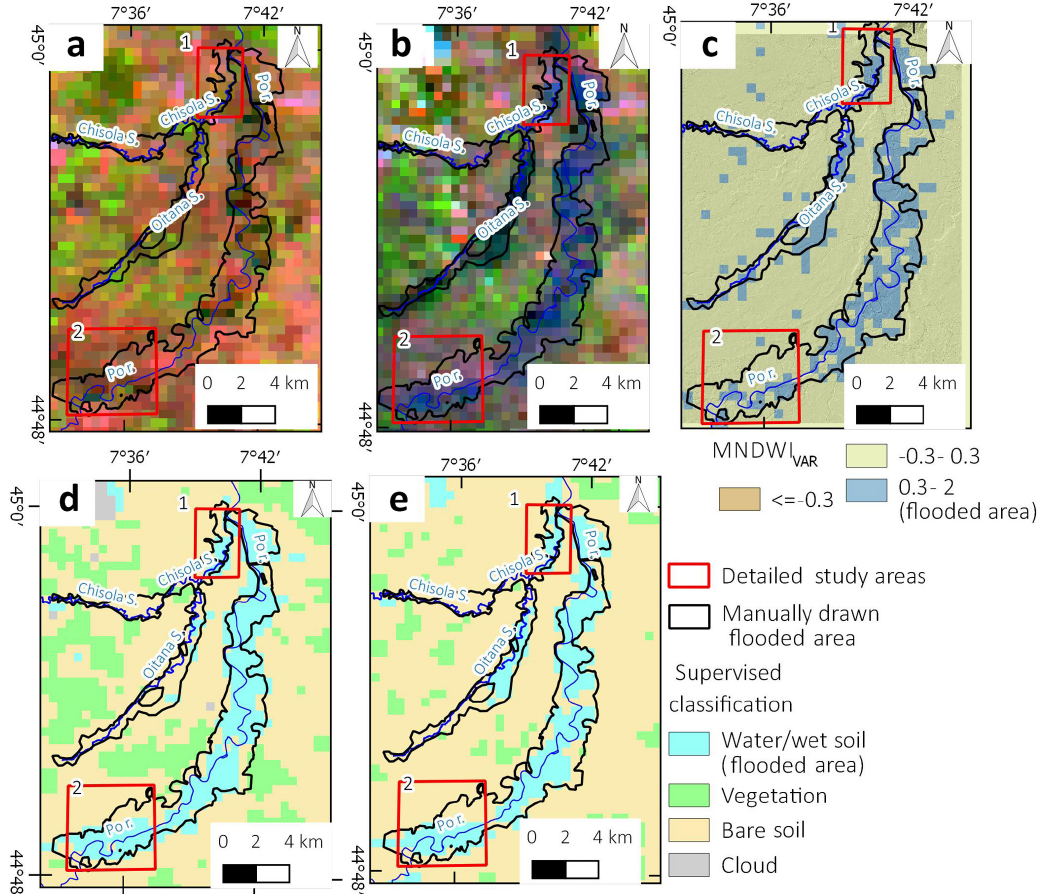
Figure 4. MODIS Aqua satellite image (a) false colour band composition 7-2-1 acquired on 12 November 2016; (b) false colour band com- position 7-2-1 acquired during the 26 November 2016 event; (c) automatic detection of the flooded area using MNDWI var > 0.3; automatic detection of the flooded area using supervised classification with maximum likelihood method (d) and with spectral angle method (e) . The red box identifies the local case history of Moncaleri (1) and Pancalieri